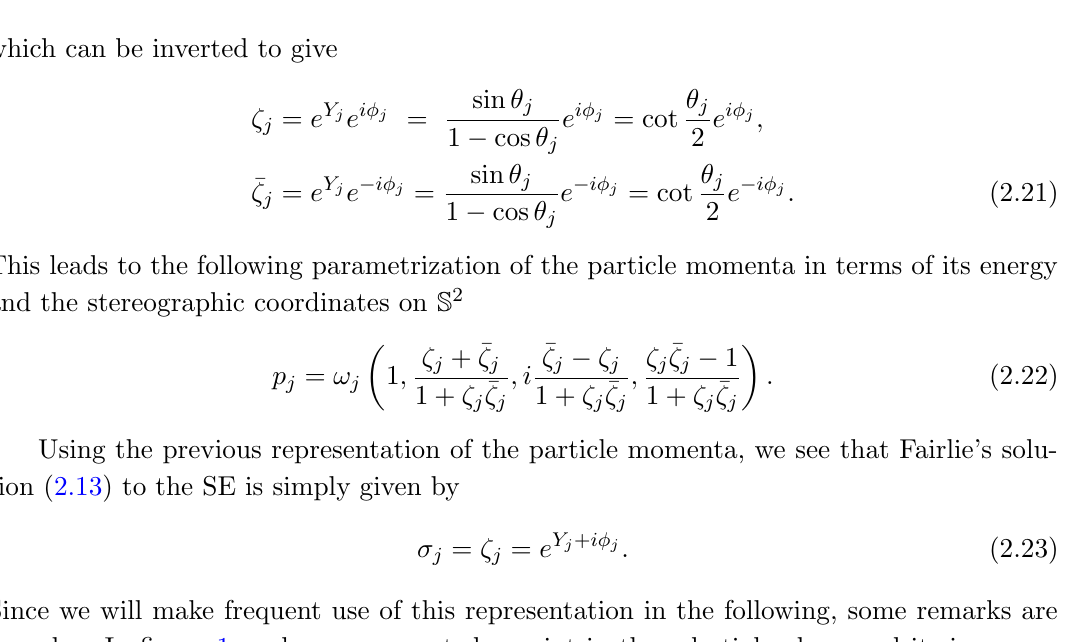
Figure 1 . Geometric interpretation of the rapidity Y j and azimuthal angle (cid:30) j